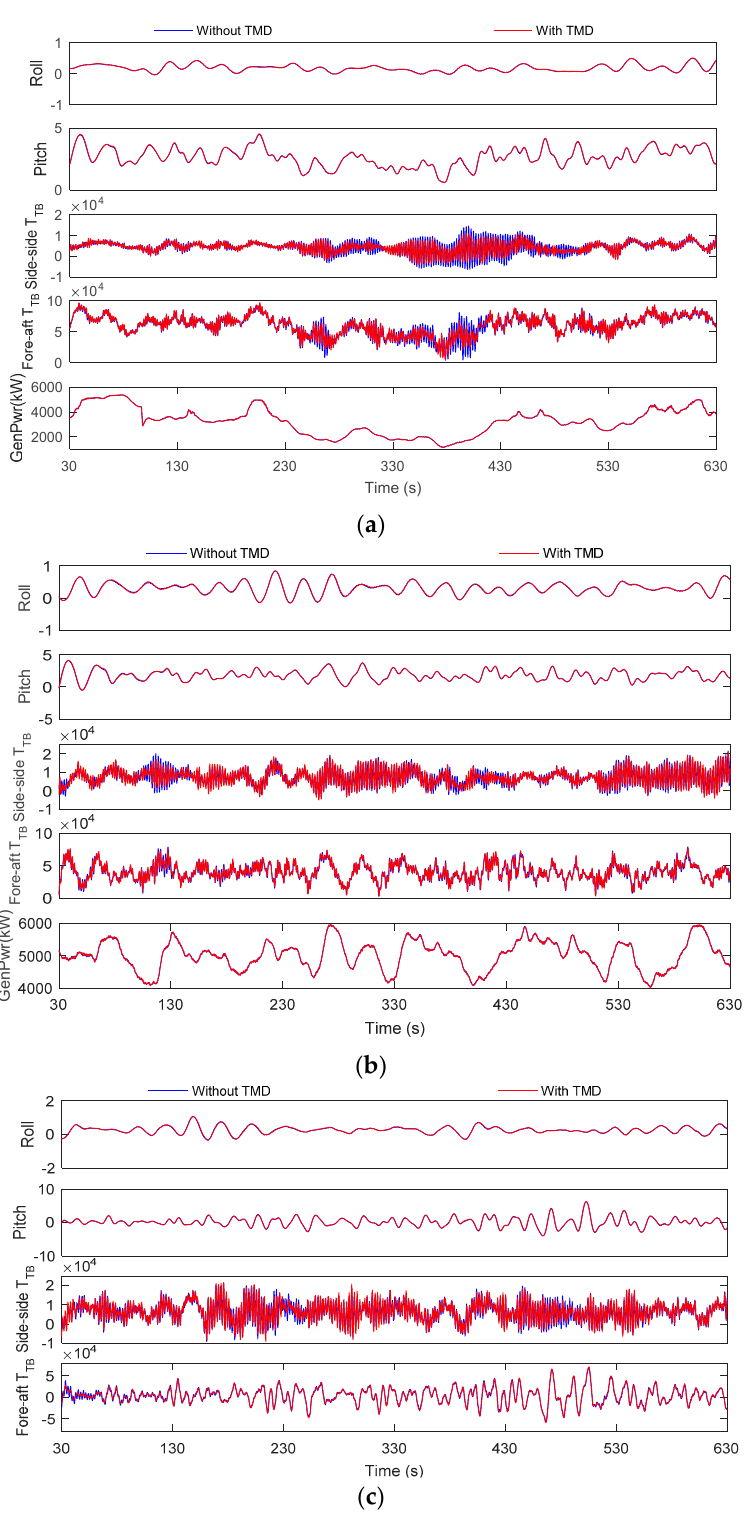
Figure 8. Time-histories of response under three load conditions with and without TMD: ( a ) 10 m/s; ( b ) 18 m/s; and ( c ) 37 m/s.